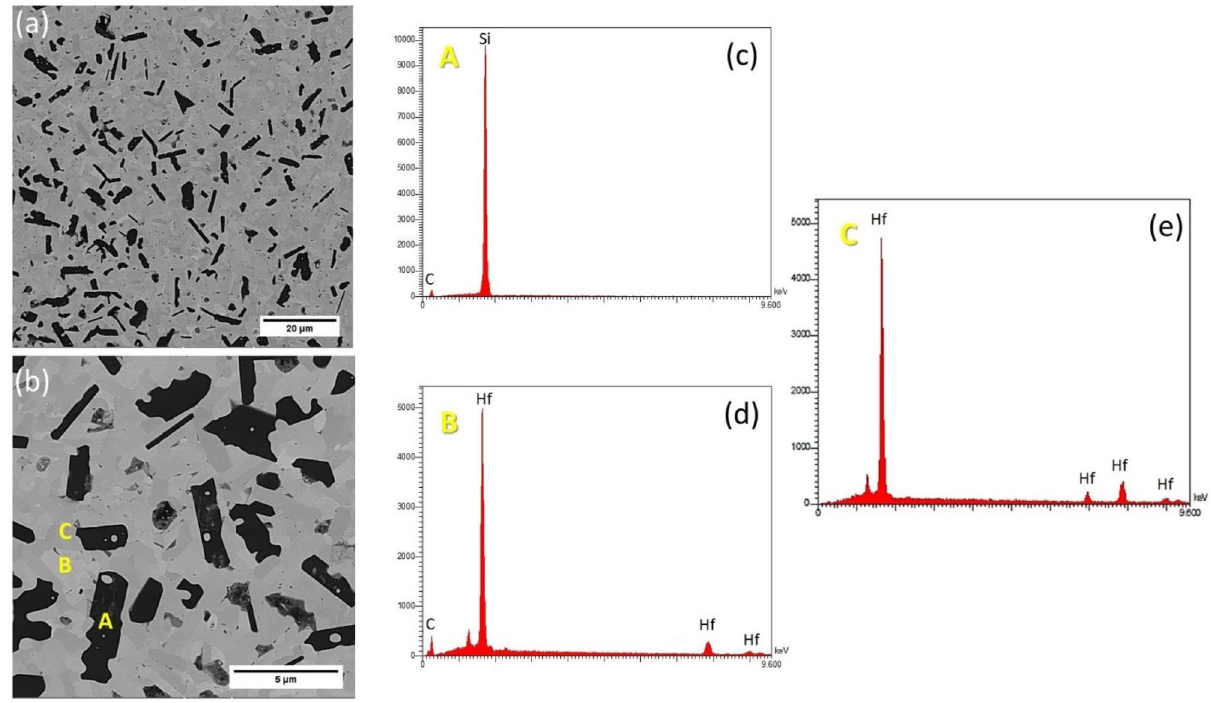
Figure 3. Backscattered image of HS20 ( a ) low magnification, ( b ) high magnification, ( c ) EDS pattern spot scan for A, ( d ) EDS pattern spot scan for B, and ( e ) EDS pattern spot scan for C.